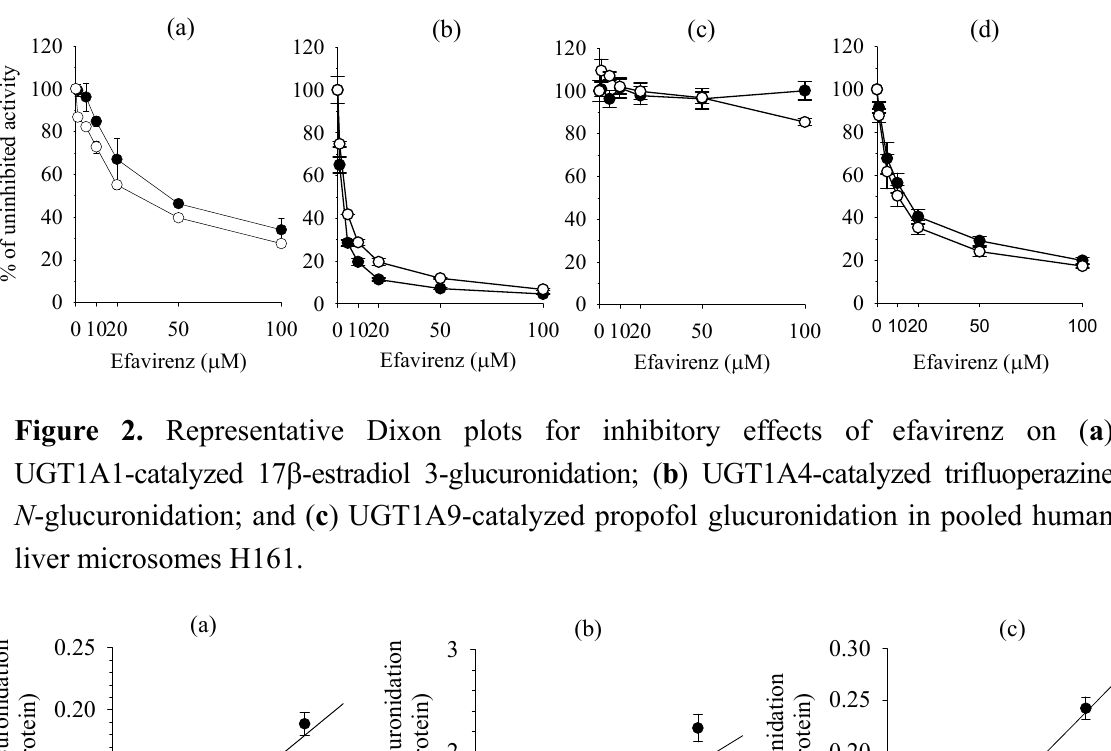
Figure 1. Inhibitory effect of efavirenz on ( a ) UGT1A1-catalyzed 17  -estradiol 3-glucuronidation; ( b ) UGT1A4-catalyzed trifluoperazine N -glucuronidation; ( c ) UGT1A6-catalyzed naphthol 1-glucuronidation; and ( d ) UGT1A9-catalyzed propofol glucuronidation in pooled human liver microsomes H161 (  ) and each human cDNA-expressed UGT1A1, 1A4, 1A6, and 1A9 supersomes (  ).